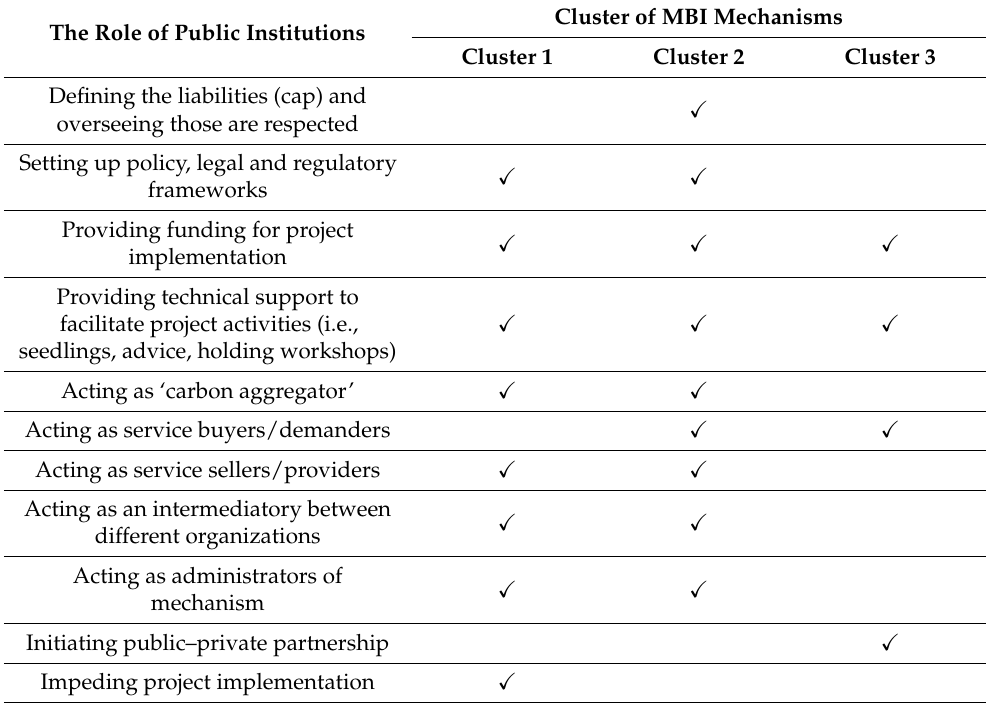
Table 4. Role of public institutions in each cluster identified in the